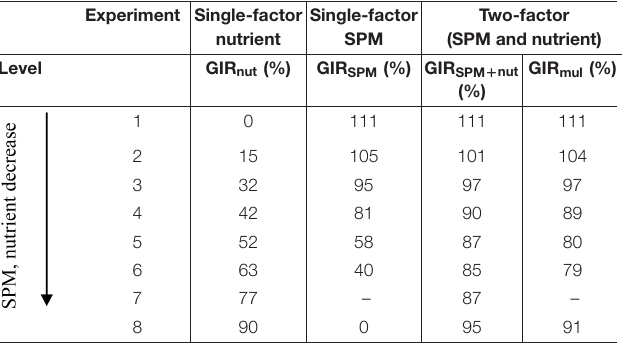
TABLE 4 | Growth inhibitory rate (GIR) of A. carterae under different culture settings. Experiment Single-factor